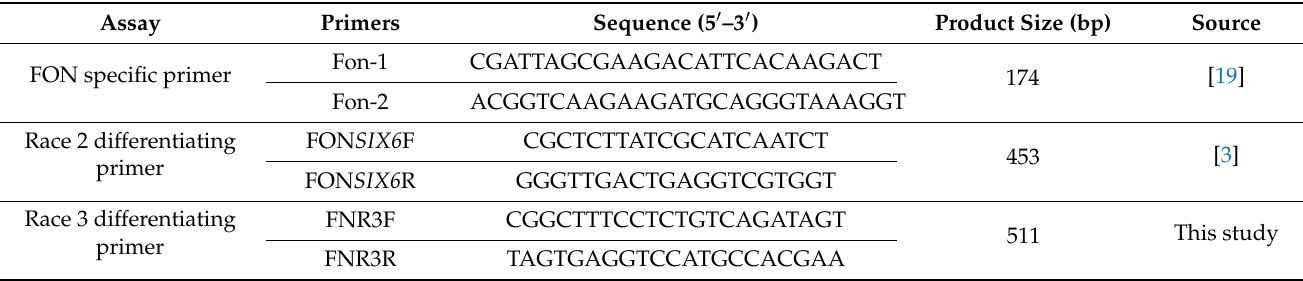
Table 2. List of primers used in this